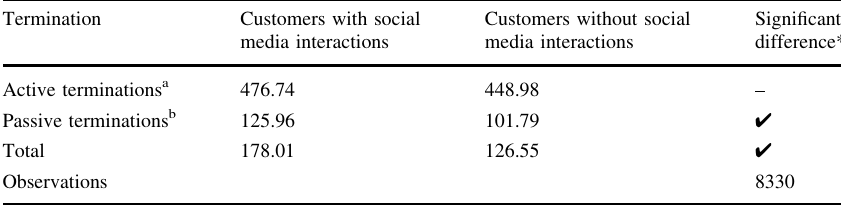
Table 5 Comparison of average customer lifetime until contract